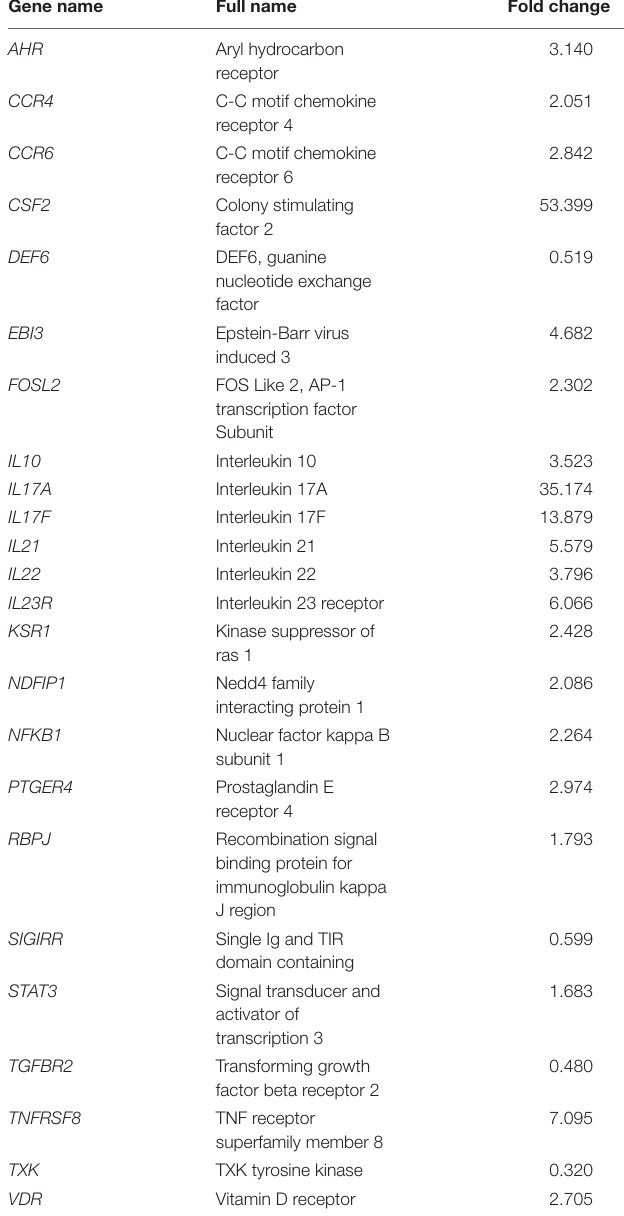
TABLE 2 | Literature-validated Th17 signature genes (from Ciofani et al., 2012) selected from the significantly differentially expressed (DE) genes after digoxin treatment in Th17 cells determined using RNA-seq.